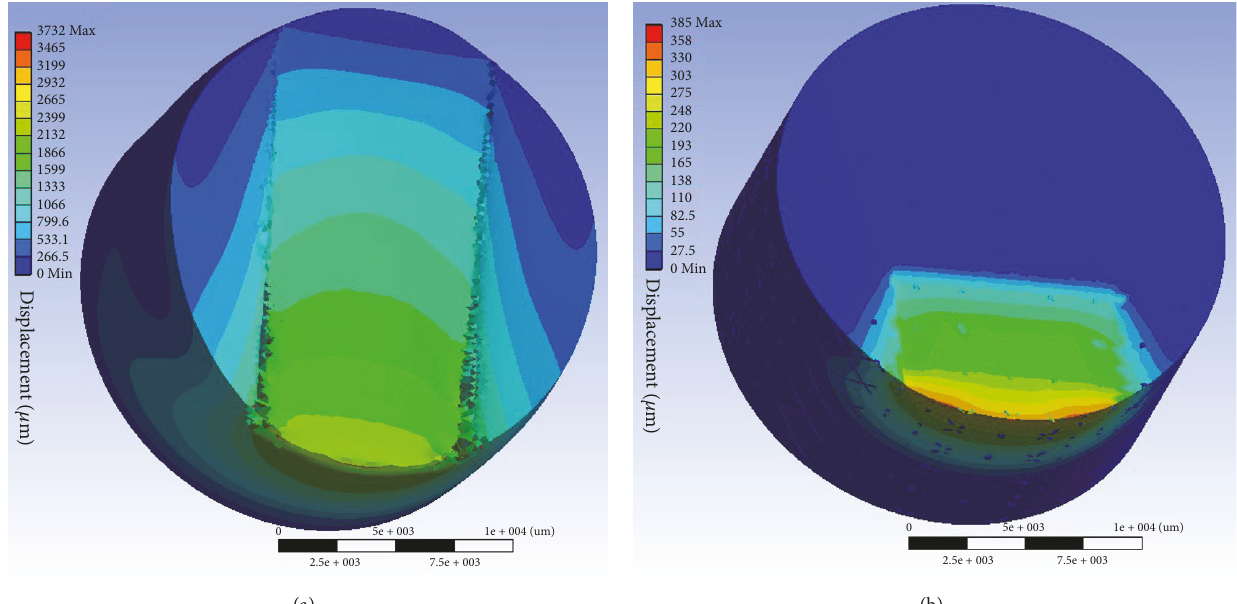
Figure 13: Displacement of 1000 J impact simulation of samples: (a) pure diamond and (b) diamond and Ti6Al4V